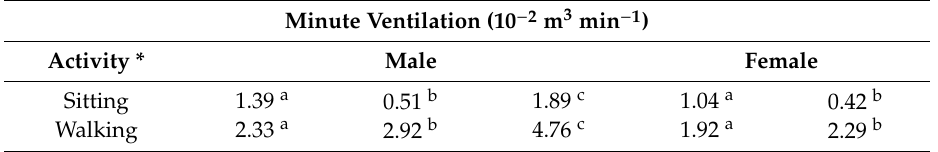
Table 2. Comparison of minute ventilation from di ff erent literature for various activity